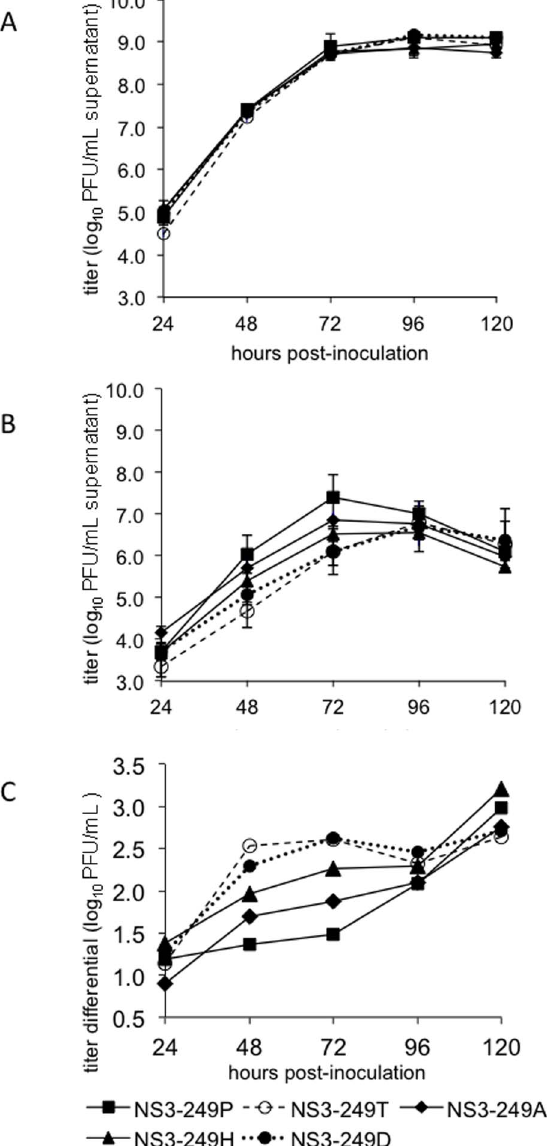
Figure 7. Temperature sensitivity assessment in an avian (DEF) cell line performed at 37 6 C (A) and 44 6 C (B). Cells were inoculated at an MOI of 0.1 and titers determined by plaque titration on Vero cells. (C) Depicts a compilation of the differential growth by subtracting titers determined from growth at 37 u C from those observed at 44 u C.